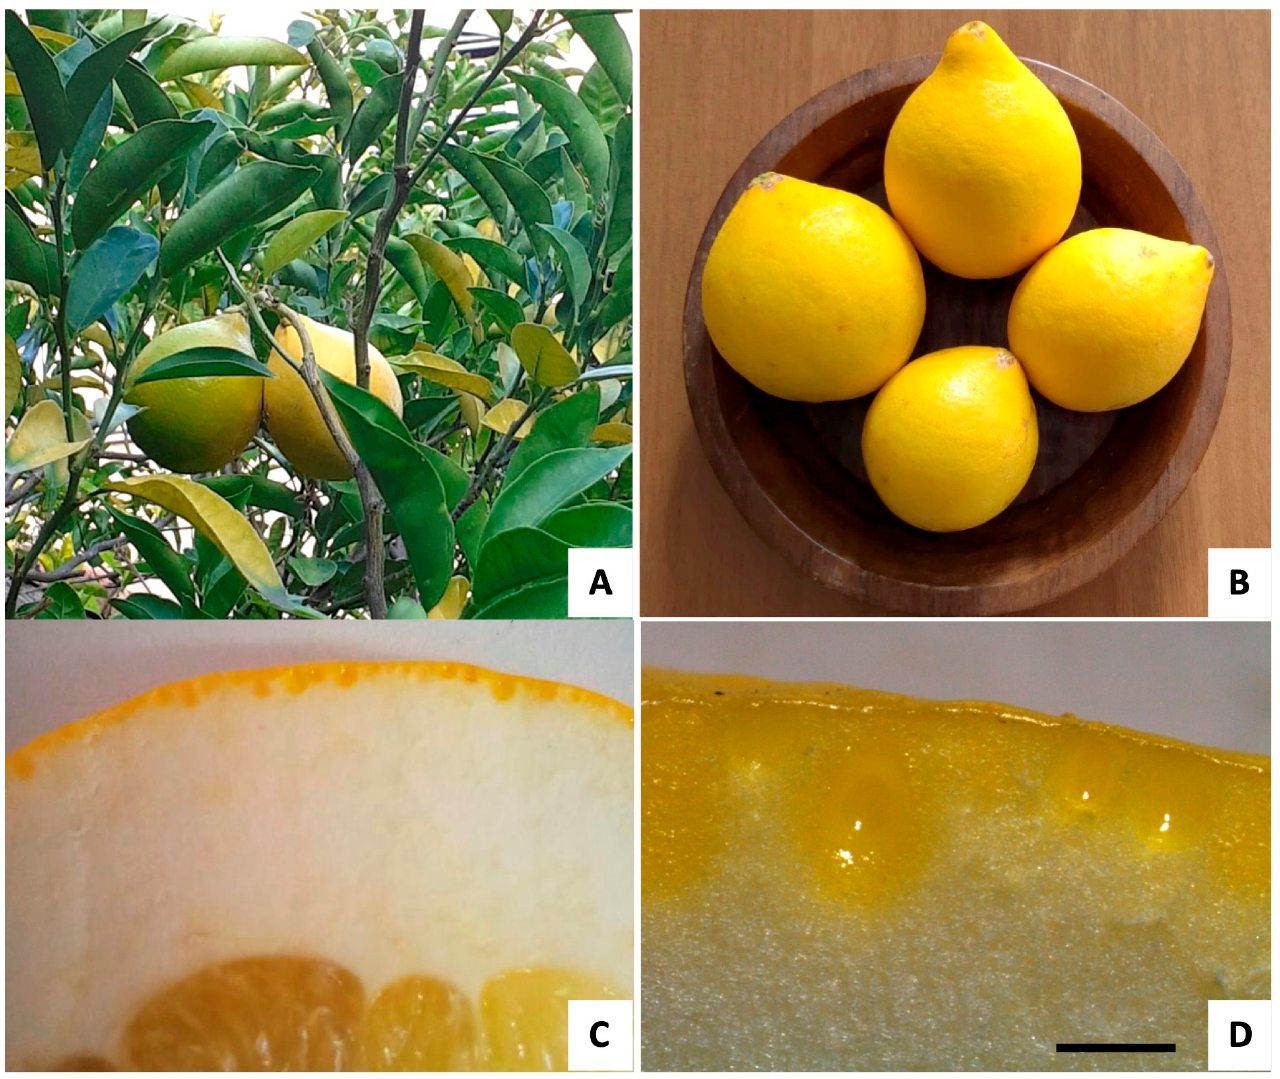
Figure 1. Citrus lumia ‘Pyriformis’. ( A ) Plant growing at the Hanbury Botanical Gardens (Ventimiglia, Italy). ( B ) Mature fruits. ( C ) Transversal section of the peel, showing the pigmented flavedo and the white albedo. ( D ) Detail of the flavedo with spherical to ellipsoidal/pyriform oil cavities. Scare bar: 1 mm.